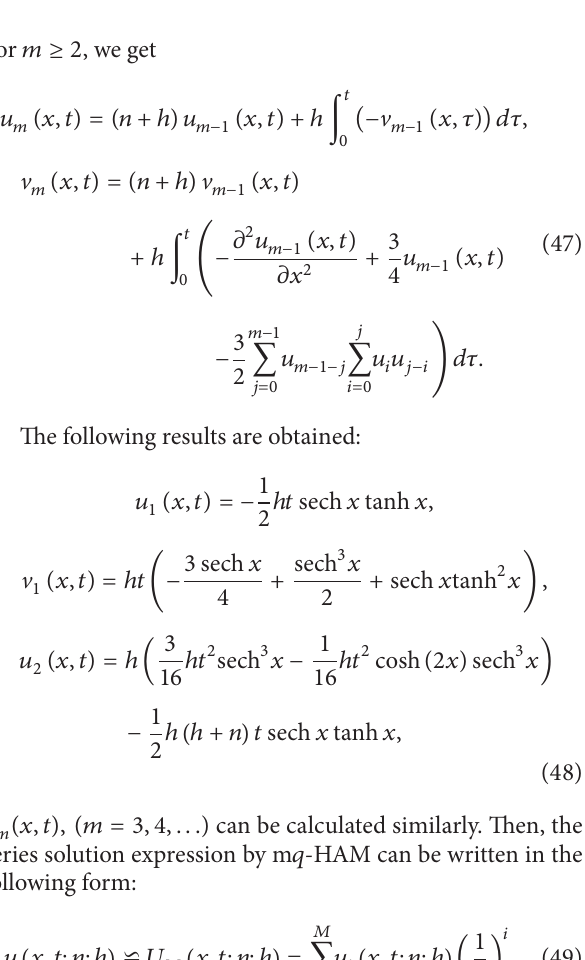
Figure 10: ℎ -curve for the m 𝑞 -HAM ( 𝑛 = 100) approximation solution 𝑈 6 (𝑥,𝑡;100) of problem (40) at different values of 𝑥 and 𝑡 .